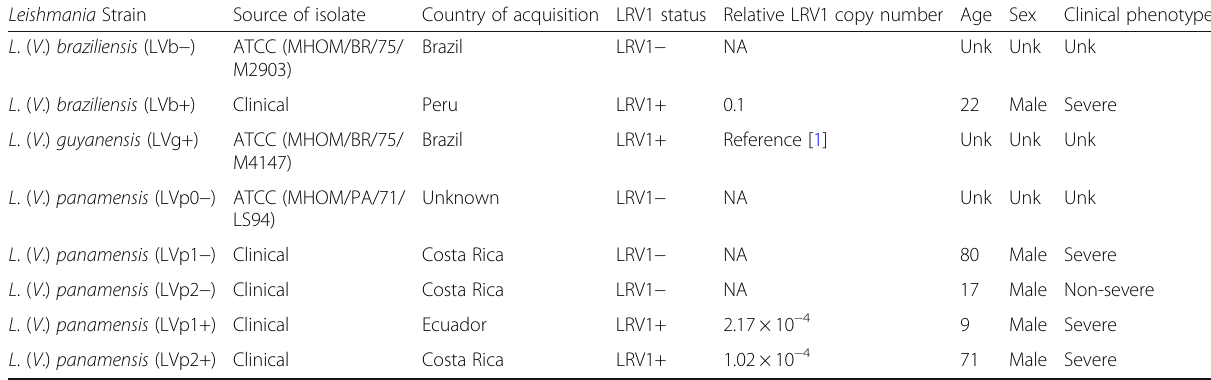
Table 1 Classification of Leishmania spp. strains used in experiments Leishmania